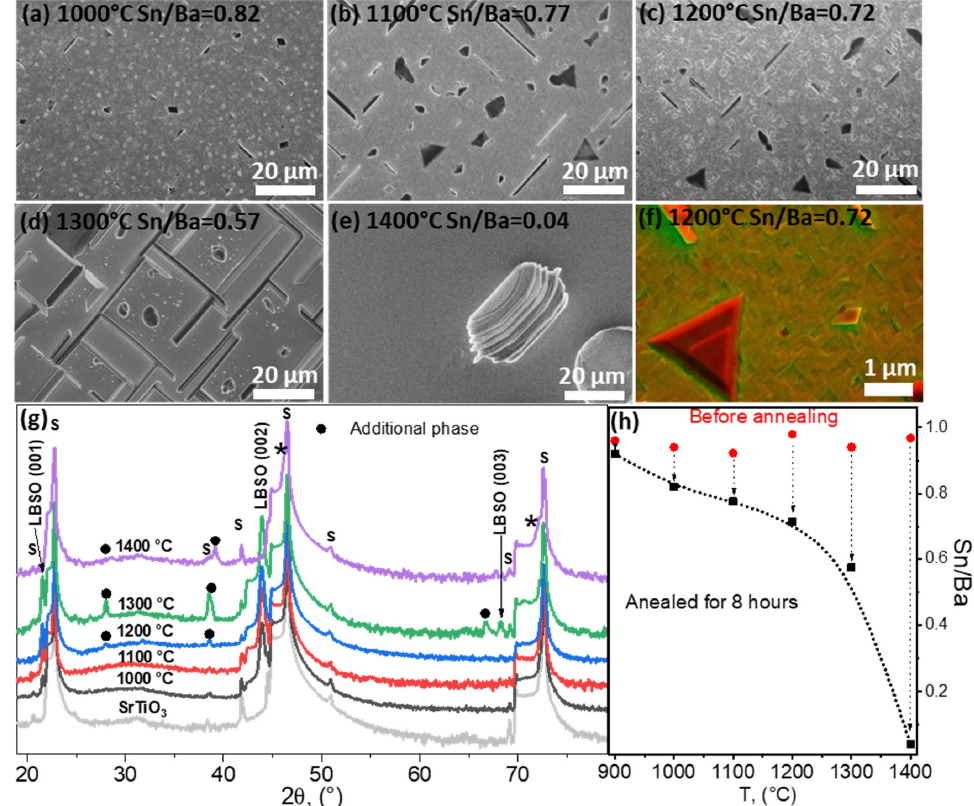
Figure 5. ( a – e ) SEM images of thin LBSO films annealed at different temperatures and their compo ‐ sitions after annealing determined using EDX. ( f ) SEM image using backscattered and secondary electron detectors simultaneously. ( g ) XRD parallel ‐ beam scans of annealed thin La ‐ doped BaSnO 3 (ICDD PDF #04 ‐ 018 ‐ 6953) films deposited on (100) STO (ICDD PDF #00 ‐ 005 ‐ 0634) (marked by “s”). Black dots and asterisks ( * ) mark possible additional phases: (Ba 0.30 Sr 0.70 )TiO 3 (ICDD PDF #04 ‐ 008 ‐ 0742), (Ba 0.59 Sr 0.408 )TiO 3 (ICDD PDF #01 ‐ 070 ‐ 3628), and Ba 0.97 La 0.3 SnO 3 (ICDD PDF #04 ‐ 018 ‐ 6953). ( h )